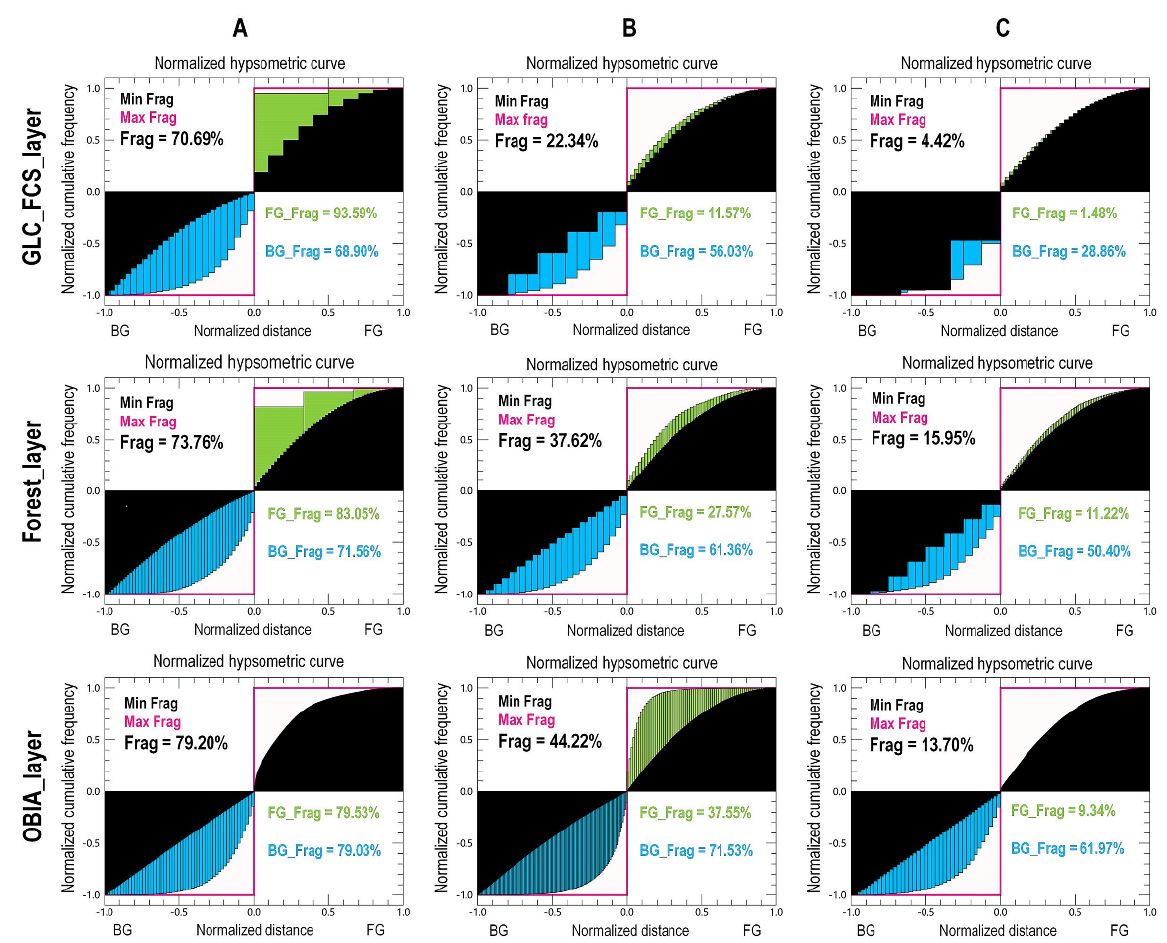
Figure 4. NLHCs calculated for study areas with different UGS cover maps across urban gradients. The distributions of urban gradient scenario A, B, and C are in Figure 1. The overall fragmentation index is shown at the top left corner in each chart, while fragmentation of its foreground (i.e., forest) component is shown in green, and its background component (i.e., non-forest) is in blue. The degree of fragmentation corresponds to the area under the NLHC covered between minimum possible fragmentation (black) and maximum fragmentation (red).